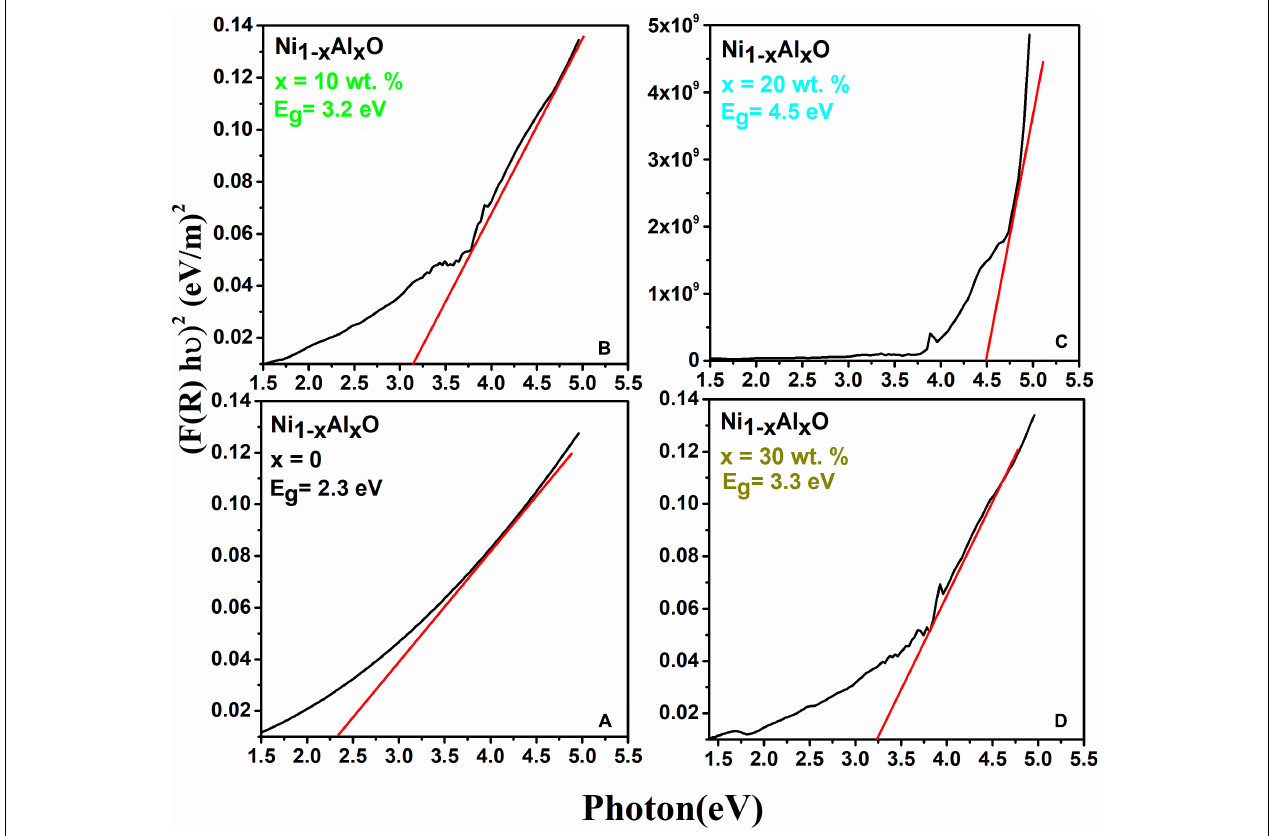
FIGURE 4 | (A–D) Variation of energy band gaps of Ni 1 − x Al x O; x = 0, 10, 20 and 30 wt.% nanoparticles, respectively.